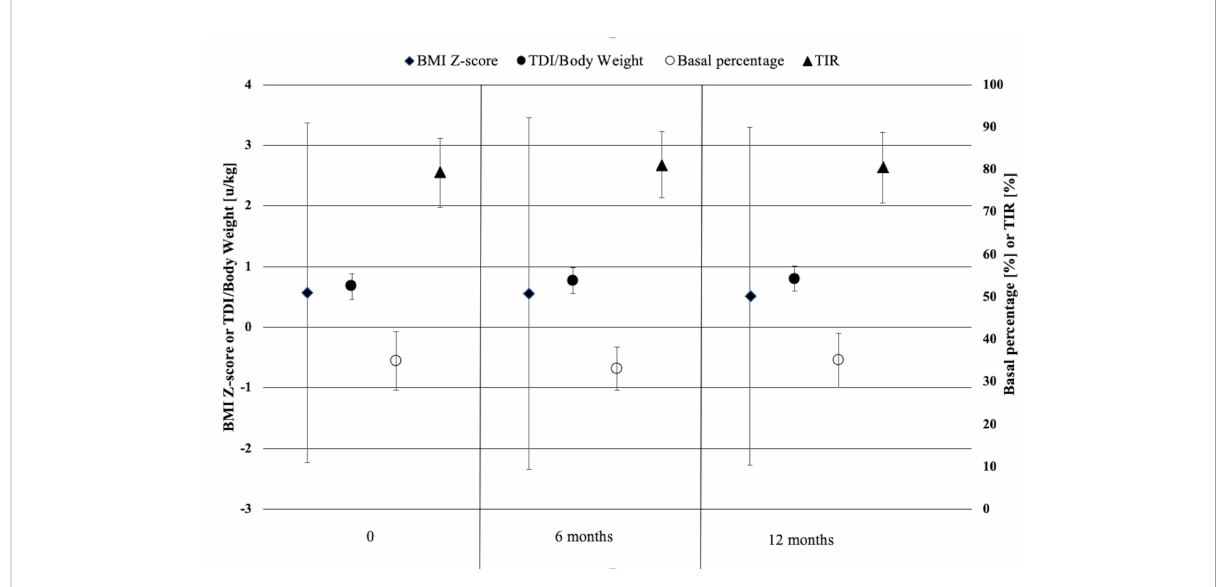
FIGURE 1 Body mass index, daily insulin doses, basal percentage and TIR of children and adolescents with type 1 diabetes using the advanced hybrid closed-loop system at initiation of the system, at 6 months and 1 year of